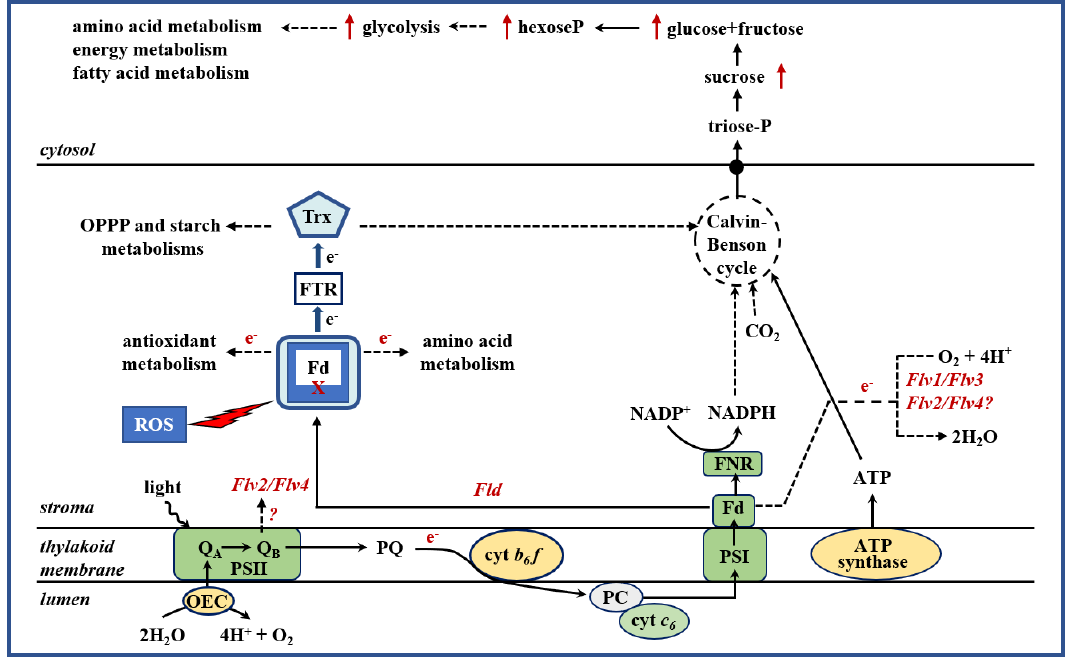
Figure 1. Schematic representation of the AET pathways associated with alternative electron carriers expressed in plants. Inactivation of the photosynthetic machinery caused by environmental constraints such as drought results in an overpro- duction of reactive oxygen species (ROS) and a decline of ferredoxin (Fd), the final acceptor of the photosynthetic electron transport chain, which in turn negatively affects the reduction of thioredoxin (Trx) by Fd-Trx reductase (FTR). This system participates in the redox modulation of components of the Calvin – Benson cycle, starch biosynthesis, the oxidative pentose phosphate pathway (OPPP), and other metabolic routes. Flavodoxin (Fld) compensates for the loss of stress-sensitive Fd and maintains electron flow to productive routes of the chloroplast, resulting in improved metabolic activity and plant development. In contrast to Fld, flavodi-iron (Flv) proteins act as electron sinks by capturing the excess of electrons and transferring them to oxygen to produce water without the formation of ROS. Cytochrome c 6 (cyt c 6 ) participates in the intersystem electron shuttle. Improved electron flow through photosynthesis and other redox pathways enables plants to maintain the energy balance via a higher provision of redox equivalents and to improve their overall metabolic response, allowing them to survive multiple stress conditions that exert oxidative damage. cyt b 6 f : cytochrome b 6 f ; FNR: Fd-NADP +